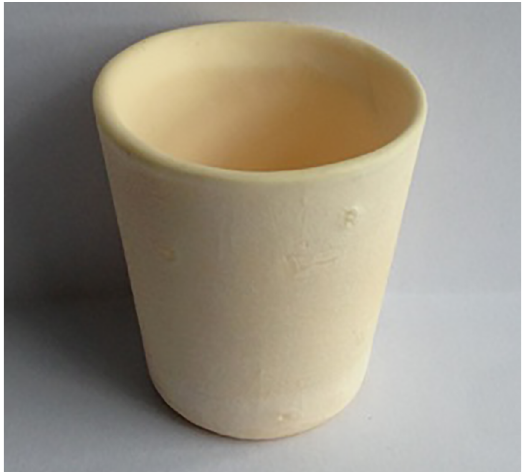
Figure 7. Conformed body after sintering up to 1600